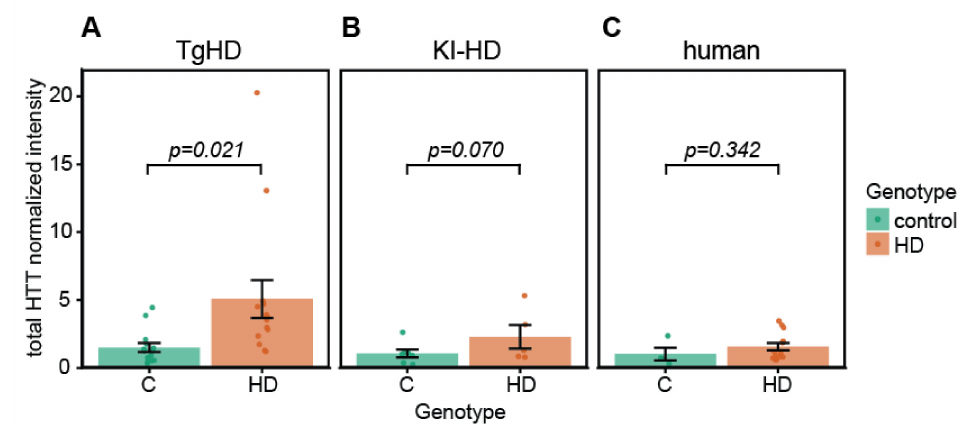
Figure 5. Normalized intensity of total huntingtin in extracellular vesicles isolated from blood plasma of TgHD and KI-HD pig models and human plasma. EVs were isolated by ultracentrifugation and HTT forms were detected by western blot using anti-N-terminal HTT antibody recognizing both normal and mutant HTT. HTT band intensities were quantified by ImageLab software and normalized to CD9 levels to minimize variability in EV loading amount. Significantly higher total HTT content was found in vesicles from TgHD pigs compared to WT control pigs ( A ), while in KI-HD ( B ) and HD patients ( C ) the increase in total HTT in EVs compared to controls was not significant. The dots represent individual samples, bars show mean of the groups, and error bars indicate standard error of the mean. Statistical analysis using three-way ANOVA with genotype and age and sex as factors, followed by the post-hoc Tukey HSD test was performed for pig samples. T-test was used to compare HTT intensity between HD patient and control